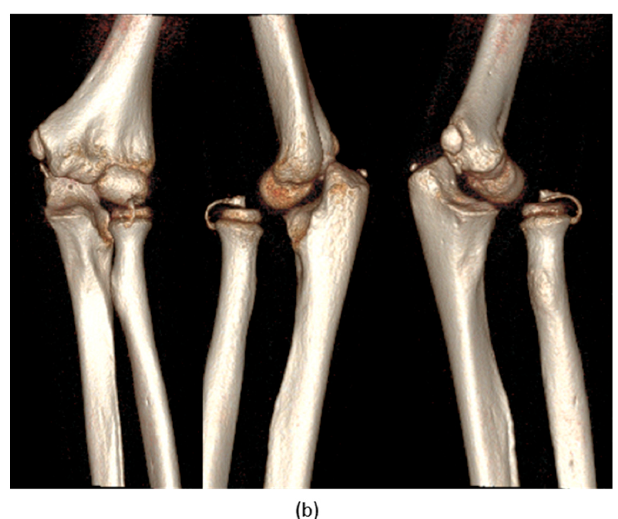
Figure 4. A nine-year-old girl with a missed Monteggia lesion. ( a ) Antero-posterior and lateral X-ray; ( b ) CT scan with 3D reconstruction: the affected elbow showed the typical dislocation of the radial head associated with bowing of the ulna. A cap calcification is visible over the radial head.